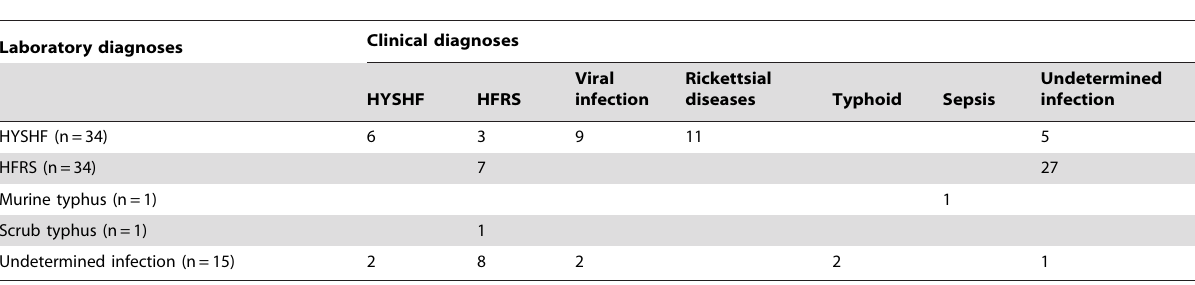
Table 3. Comparison of clinical and laboratory diagnoses of patients with